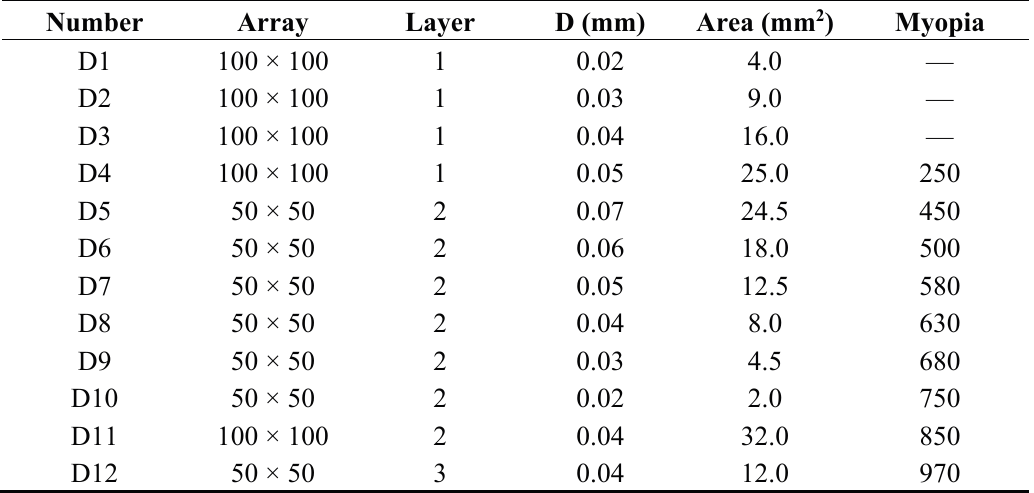
Table 1. Parameters for optical